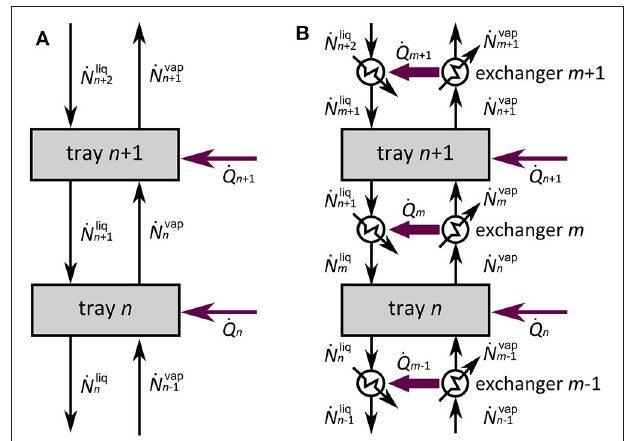
FIGURE 4 | Schematic illustration of tray n and neighboring tray n + 1 for the regular formulation of MESH equations (A) and for the case where intermediate heat exchangers m − 1, m and m + 1 are considered (B)